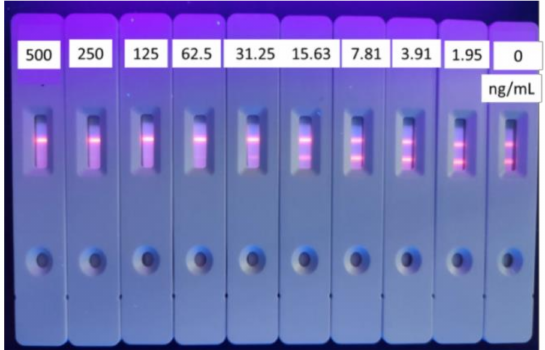
Figure 8. Standard curve for tylosin with goat anti-mouse IgG dosage of 0.075 mg/mL ( n = 3).